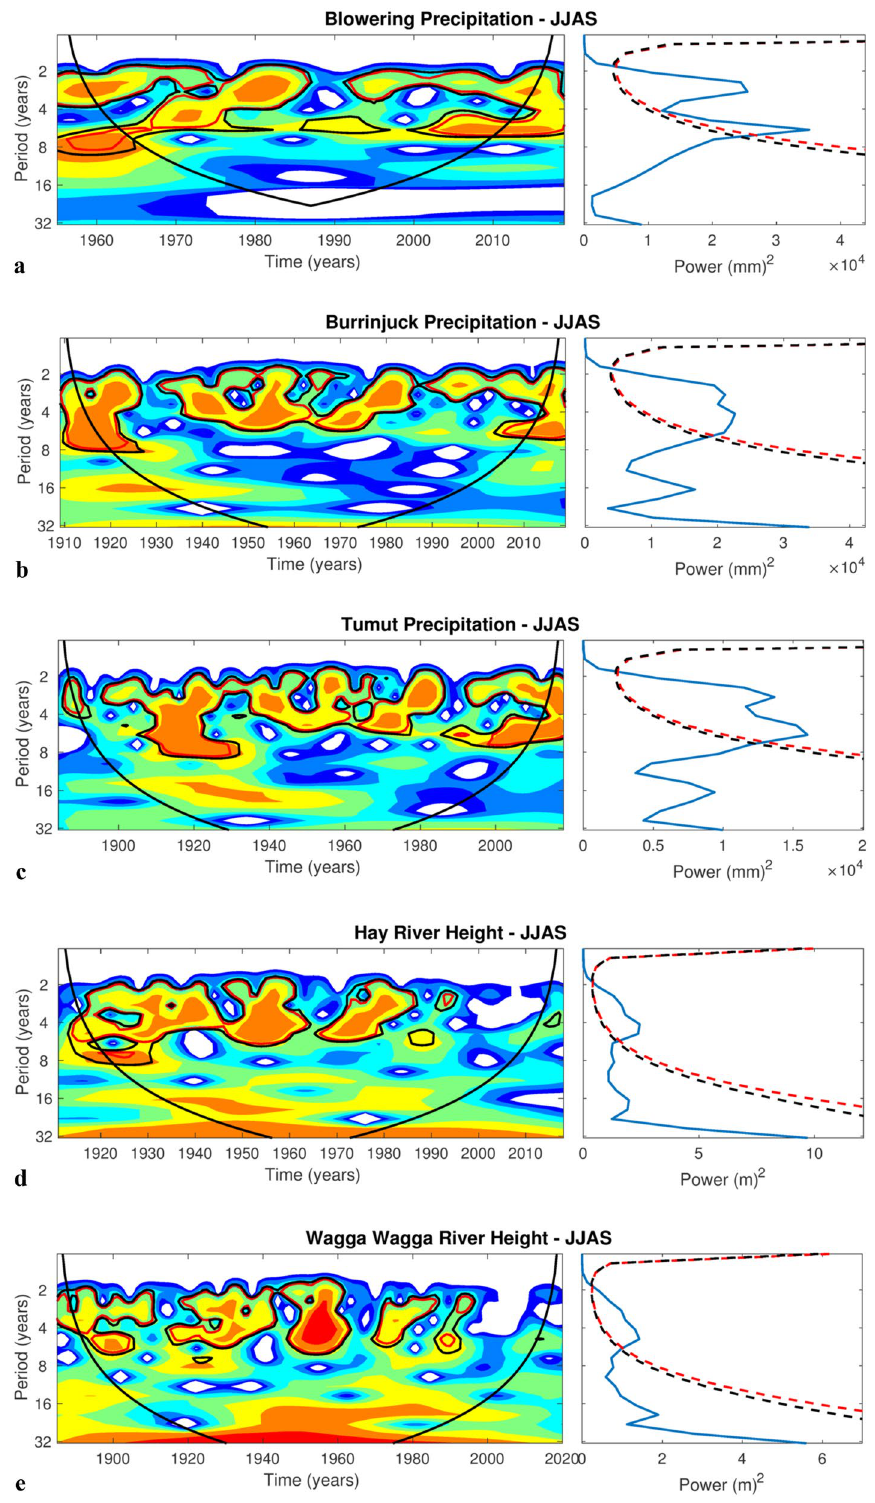
Figure 5. Wavelets of JJAS precipitation and river height. JJAS wavelets and global power spectra of precipitation for, ( a) Burrinjuck Dam, ( b) Blowering Dam, ( c) Tumut; and ( d) JJAS mean weekly Murrumbidgee river heights at Hay. Power significance is indicated by areas within thick black or red contours the 5% or 10% confidence levels,